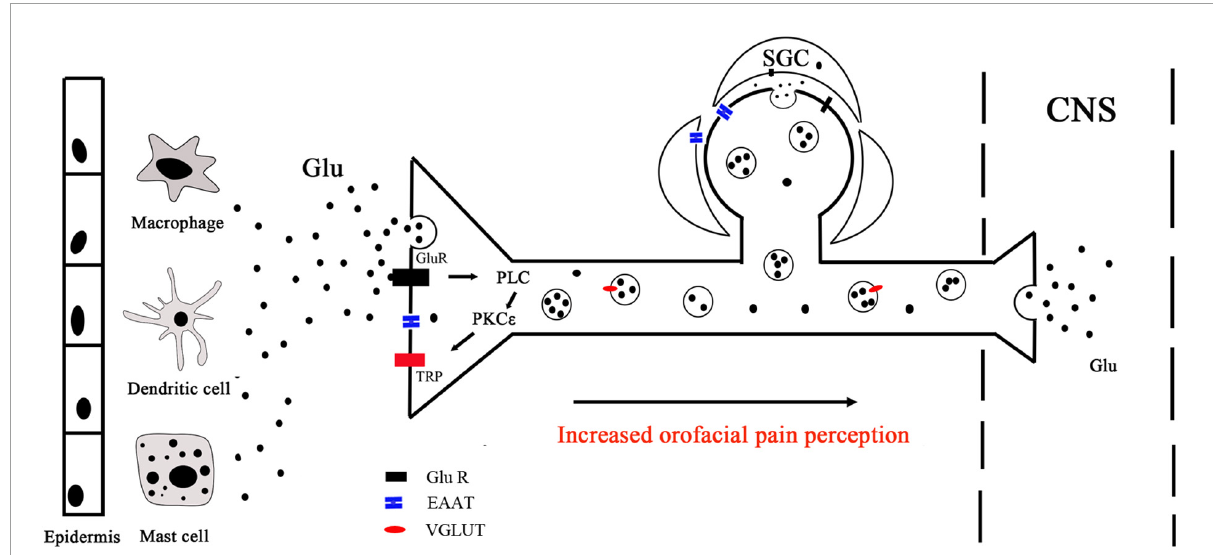
FIGURE3 Peripheral glutamate mechanisms. Peripheral glutamate plays an important role in the transmission of nociception under normal and pathological conditions. Macrophages, mast cells, and dendritic cells in the epidermis and dermis are important endogenous sources of glutamate, which can be transported by EAAT. Glutamate binds to receptors and activates PLC, leading to intracellular Ca 2 + release and PKC ε activation, which ultimately activates TRP ion channels to mediate peripheral sensation. TG neurons store glutamate in vesicles (black circles) for release in the peripheral and central nervous. With the presence of noxious stimulation, nerve endings release glutamate stored in vesicles into peripheral tissues. Glutamate released from the same or a nearby terminal can interact with Glu R to activate or sensitize the